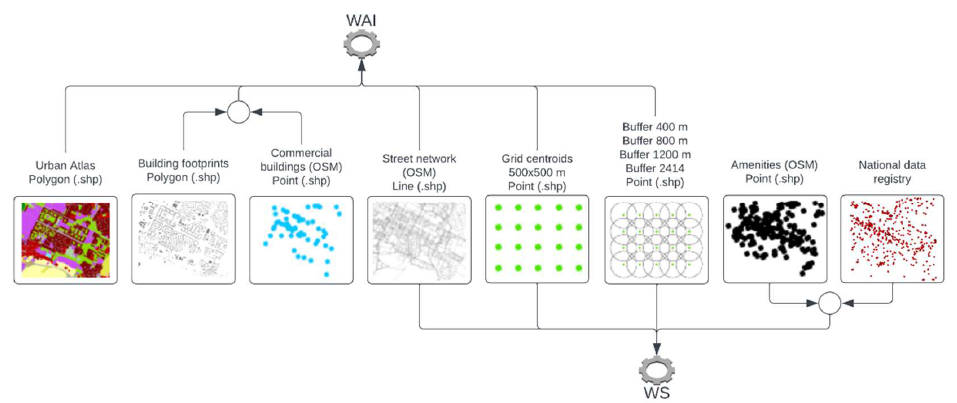
Figure 2. Location of evaluated cities.